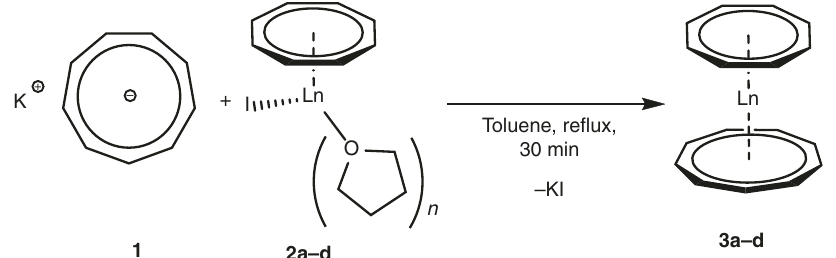
Fig. 4 General synthetic procedure part 2. Synthesis of the heteroleptic sandwich complexes [( η 9 -C 9 H 9 )Ln( η 8 -C 8 H 8 )] (Ln = Nd ( 3a ), Sm ( 3b ), Dy ( 3c ), Er ( 3d ); n = 2 (Sm, Dy, Er), 3 (Nd))